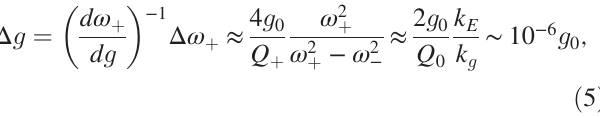
ffiffiffiffiffiffiffiffiffiffi τ = τ þ